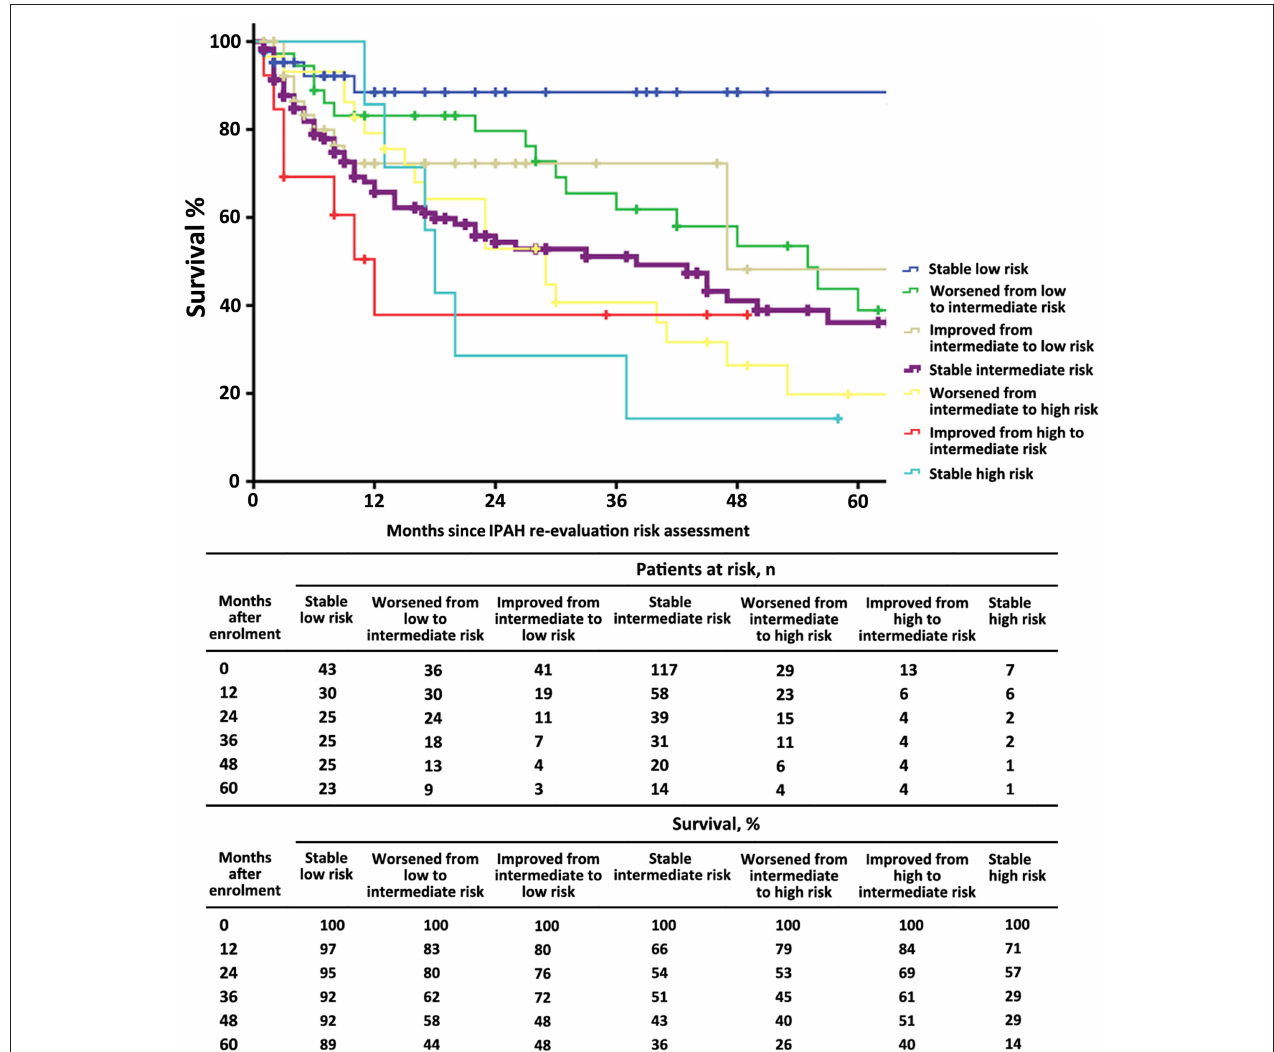
FIGURE 5 | The survival estimates in patients with idiopathic pulmonary arterial hypertension according to the 2015 ESC/ERS risk category from baseline to re-evaluation. This figure was based on n = 286 patients.